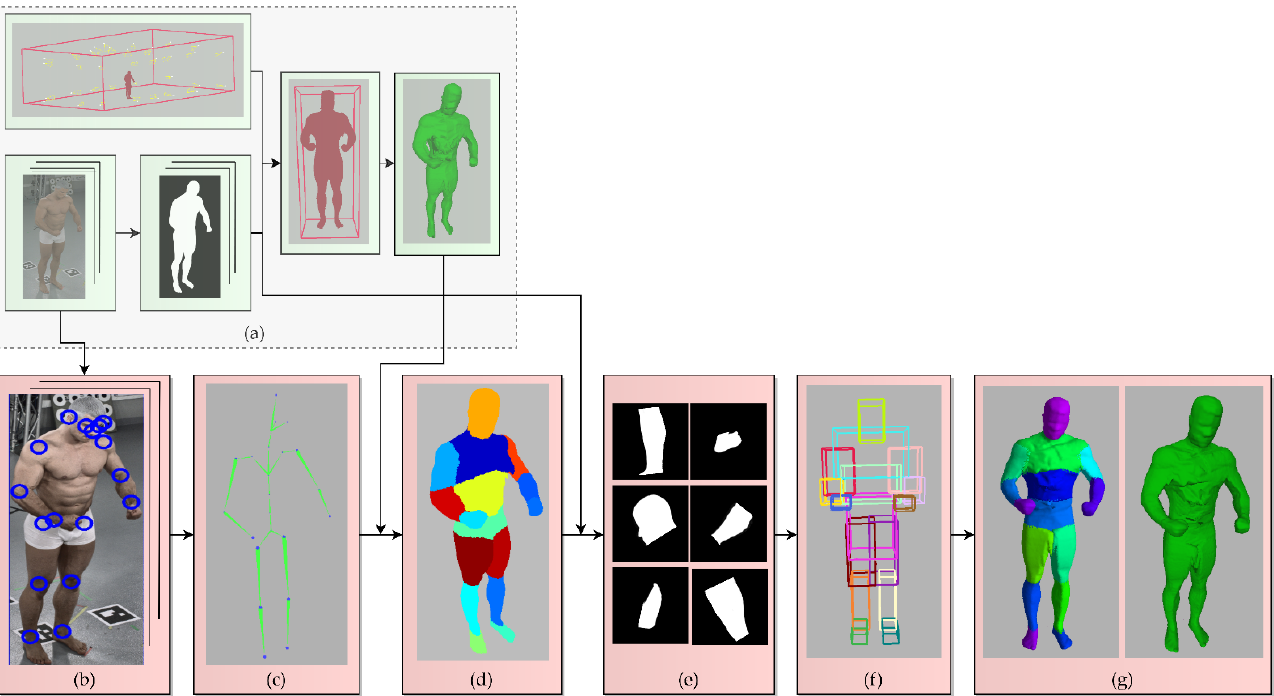
Figure 5. Proposed sSfS reconstruction approach flowchart. The steps added to the conventional SfS approach are highlighted in pink: ( a ) conventional visual hull estimation with silhouette images of an entire subject’s body (see Figure 3 for details); ( b ) results of the estimation of human joint positions on the 2D color images with a CNN-based Human Pose pre-trained model [65]; ( c ) retrieval of the 3D joint positions by casting the rays leading from each camera center’s 3D position to each joint and calculating the best intersections; ( d ) segmentation of the subject’s coarse 3D visual hull voxel reconstruction; ( e ) silhouette image segmentation by projecting the segment points onto the silhouettes (see Figure 6 for details); ( f ) estimation of the 3D volume of each body segment; ( g ) SfS reconstruction results for each body part separately and merged as a whole sSfS body model.